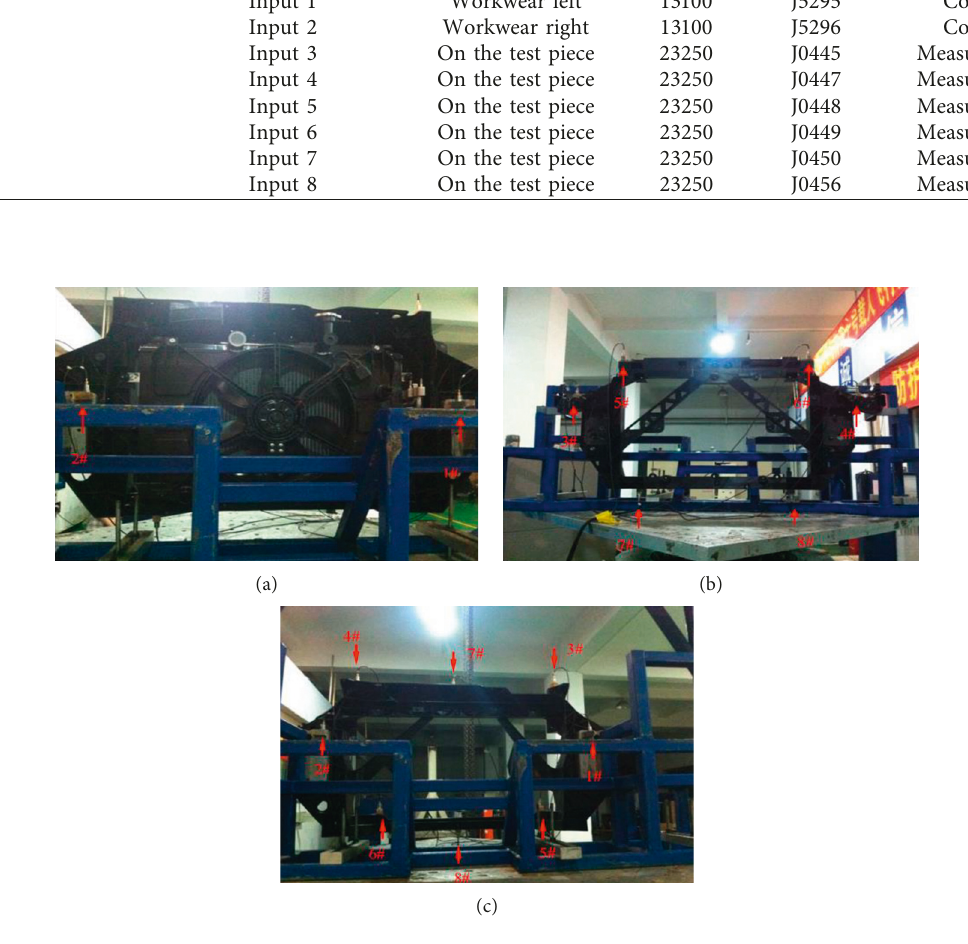
Figure 26: Sensor mounting position. (a) B-cross sensor mounting position (1# ∼ 2#); (b) B-cross sensor mounting position (3# ∼ 8#); and (c) A2 sensor installation position (1# ∼